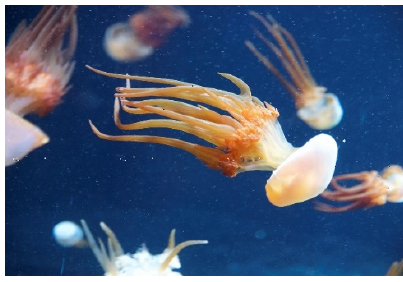
Figure 14. A specimen of Rhopilema esculentum . © Bill Abbott (CC BY-SA 2.0);